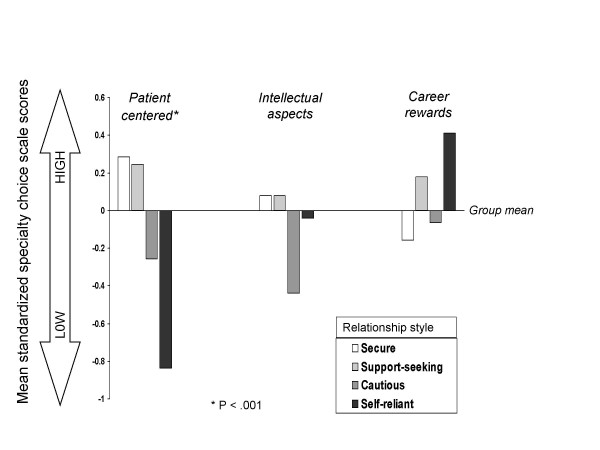
The association of relationship styles and specialty choice scale scores. Mean standardized specialty choice scale scores are illustrated for each relationship style in the specialty choice factor domains of patient centeredness, intellectual aspects and career rewards.